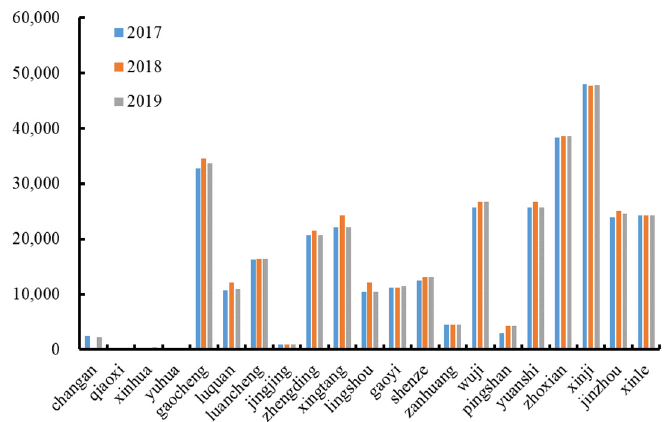
Figure 5. Changes in winter wheat area by county-level administrative region in Shijiazhuang.